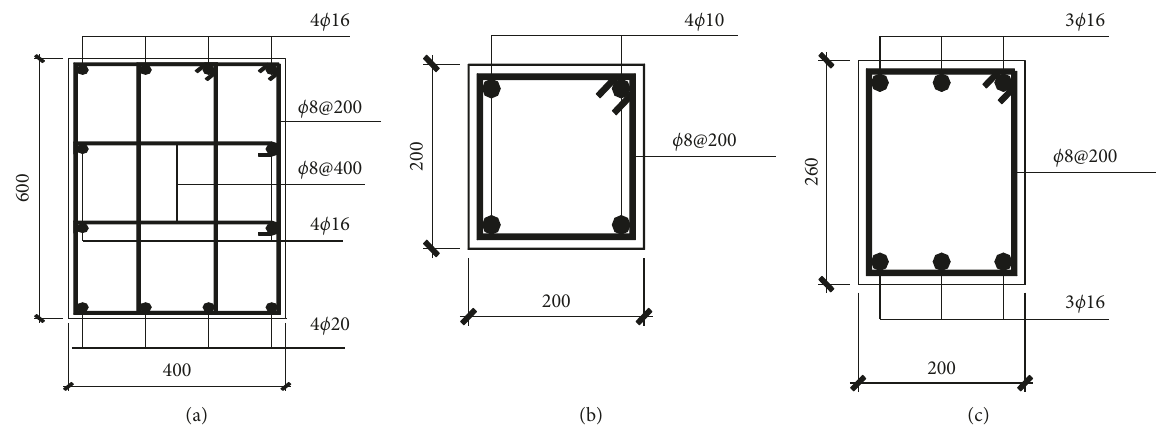
Figure 4: Reinforcement diagram of (a) ground beam, (b) structural column, and (c) ring